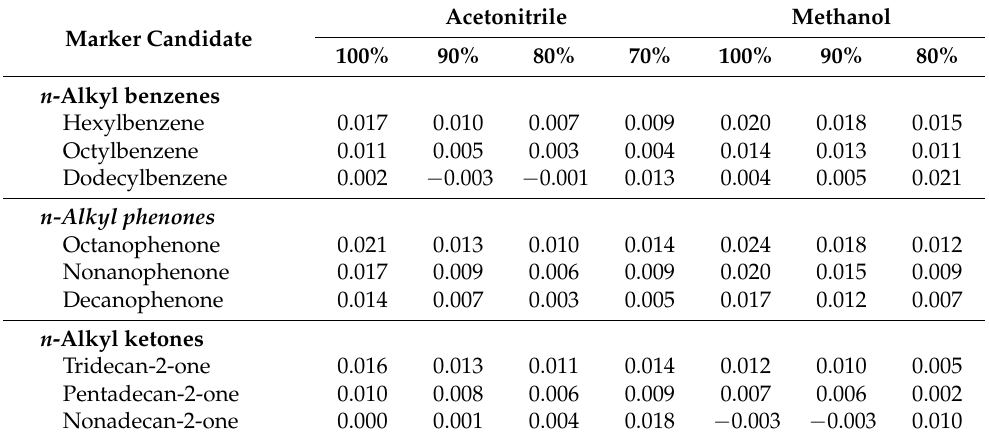
Table 3. Measured retention factors ( k ) of hold-up volume marker candidates for the ZIC-HILIC column. Marker